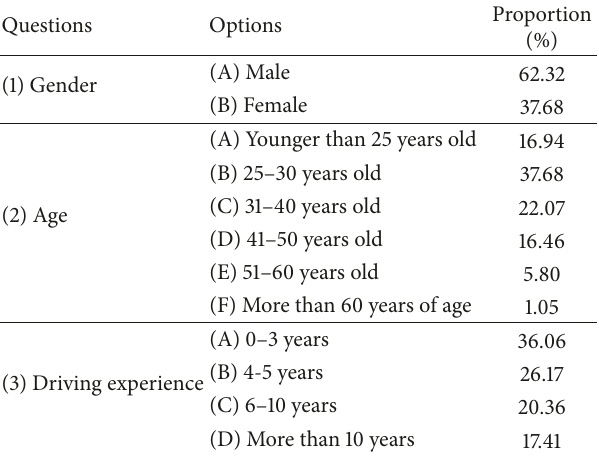
Table 1: Characteristics of drivers